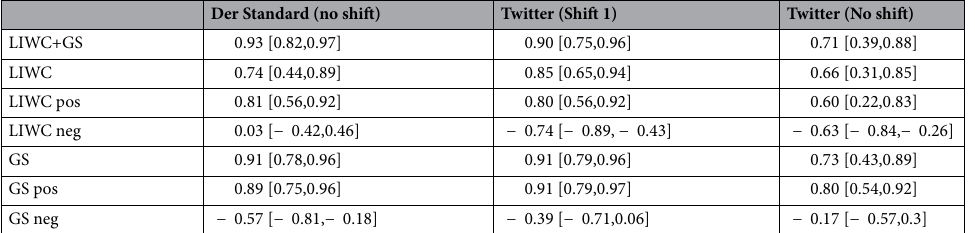
Table 1. Correlation of positive mood in the survey with text sentiment measures on both platforms (Der Standard and Twitter). The table presents sentiment aggregates (positive minus negative emotions), as well as positive and negative components separately. LIWC+GS indicates the average across both sentiment analysis methods, all other lines present aggregates or components separately for each method. Shift 1 denotes a shift of one day, where survey values precede Twitter values.